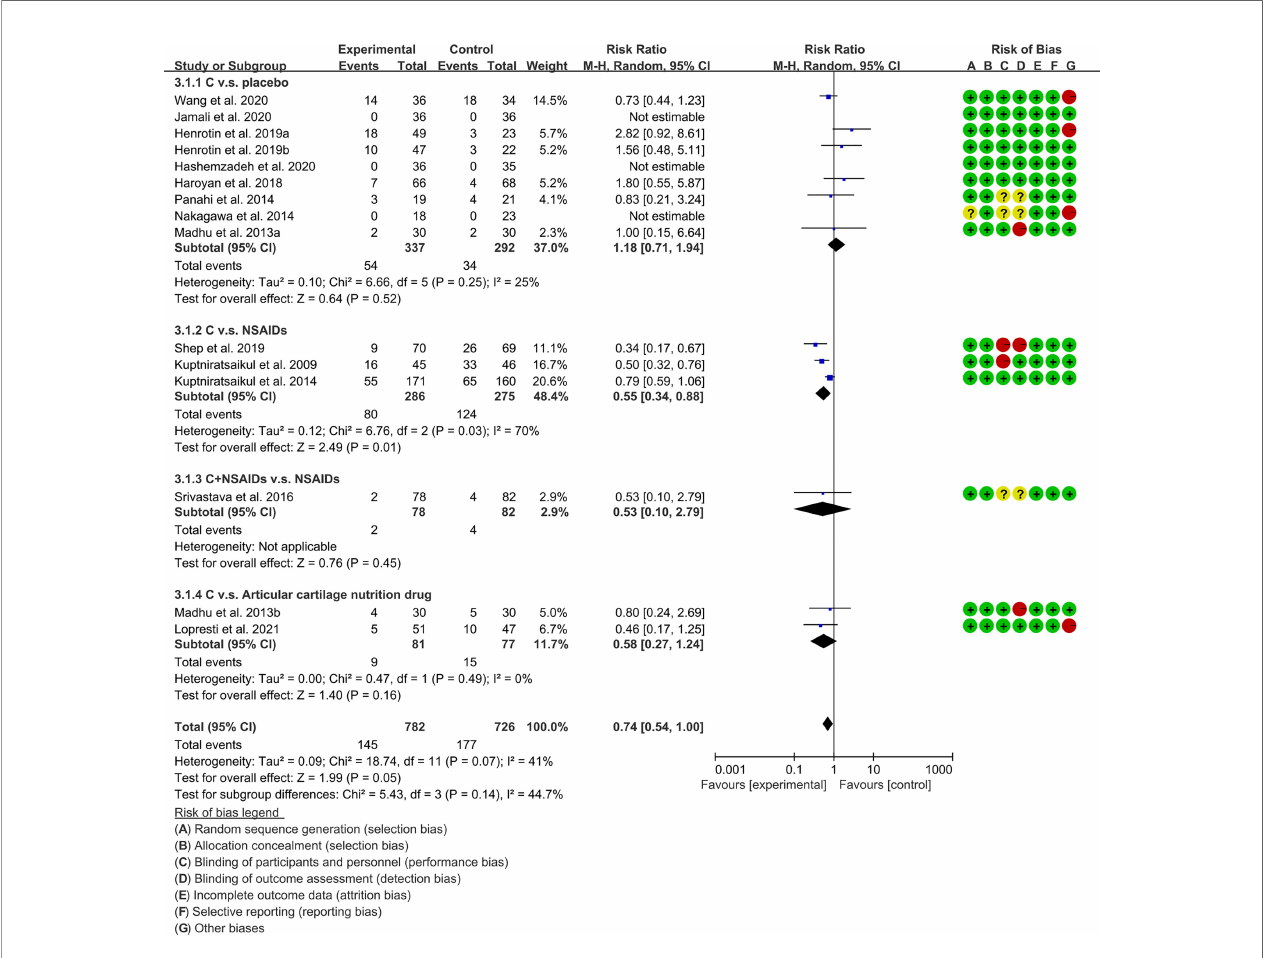
FIGURE 13 | Adverse